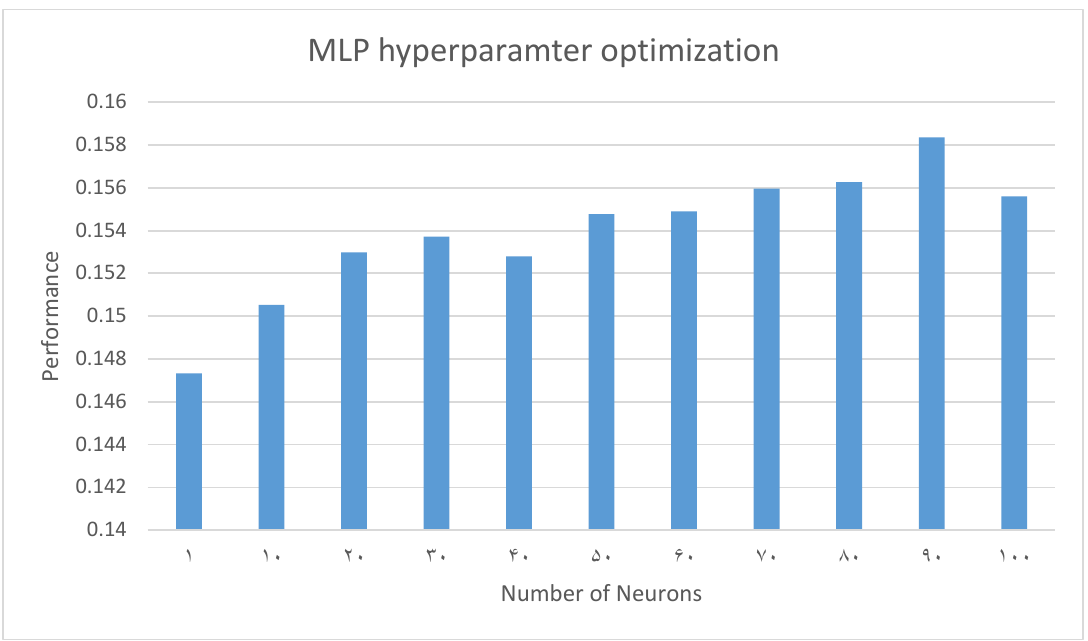
Figure A-1 Optimized number of neurons of MLP models